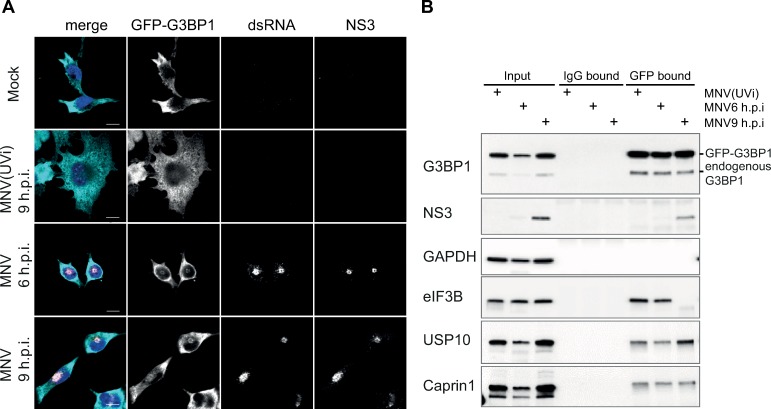
G3BP1 colocalises with MNV replication complex.GFP-G3BP1 colocalises with viral factors in MNV-infected cells (A and B). (A) Mock-, MNV(UV)- or MNV-infected BV2 GFP-G3BP1 cells (MOI 10) were incubated for 6 and 9h p.i prior fixation. Representative view (n = 2) of a confocal analysis of the subcellular distribution of GFP-G3BP1 (cyan), showing MNV replication complexes identified by double immunodetection against dsRNA (magenta) and MNV NS3 (gold). Nuclei were stained with DAPI. Scale bars, 10μm. GFP-G3BP1 co-precipitates with MNV NS3 (B). Representative western blot analysis (n = 3) of a co-immunoprecipitation assay against GFP-G3BP1 (GFP) performed in extracts of cells infected as described above. A parallel co-precipitation using a normal IgG has been used as a control (IgG). Levels of cellular and viral proteins are shown in Inputs, IgG-bound fractions and GFP-bound fractions.